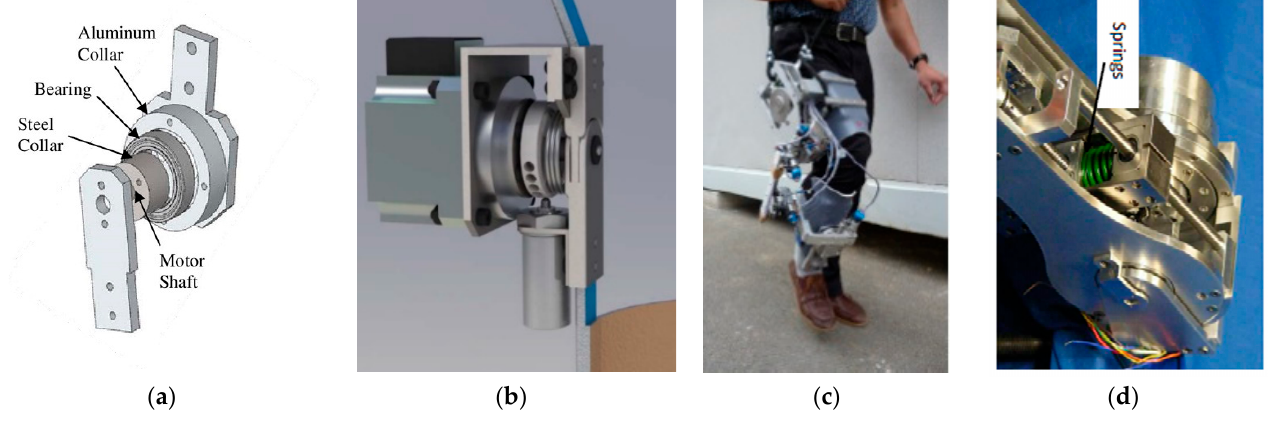
Figure 6. Knee Orthoses joints: ( a ) Lightweight adjustable exoskeleton [25], ( b ) Schematic model of orthosis actuated by a rotary motor (left) and linear motor (right) and locking system [27], ( c ) Knee joint exoskeleton [28], (d) Actuator with adjustable stiffness [17].